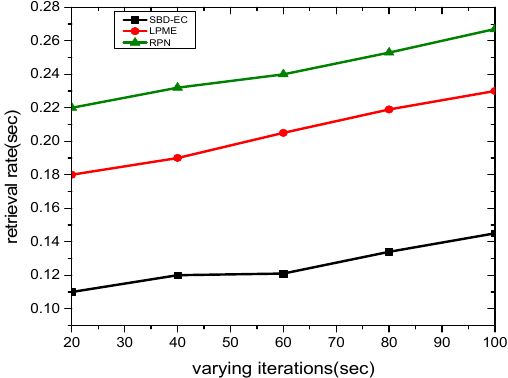
Figure 4. Data retrieval rate and iterations.